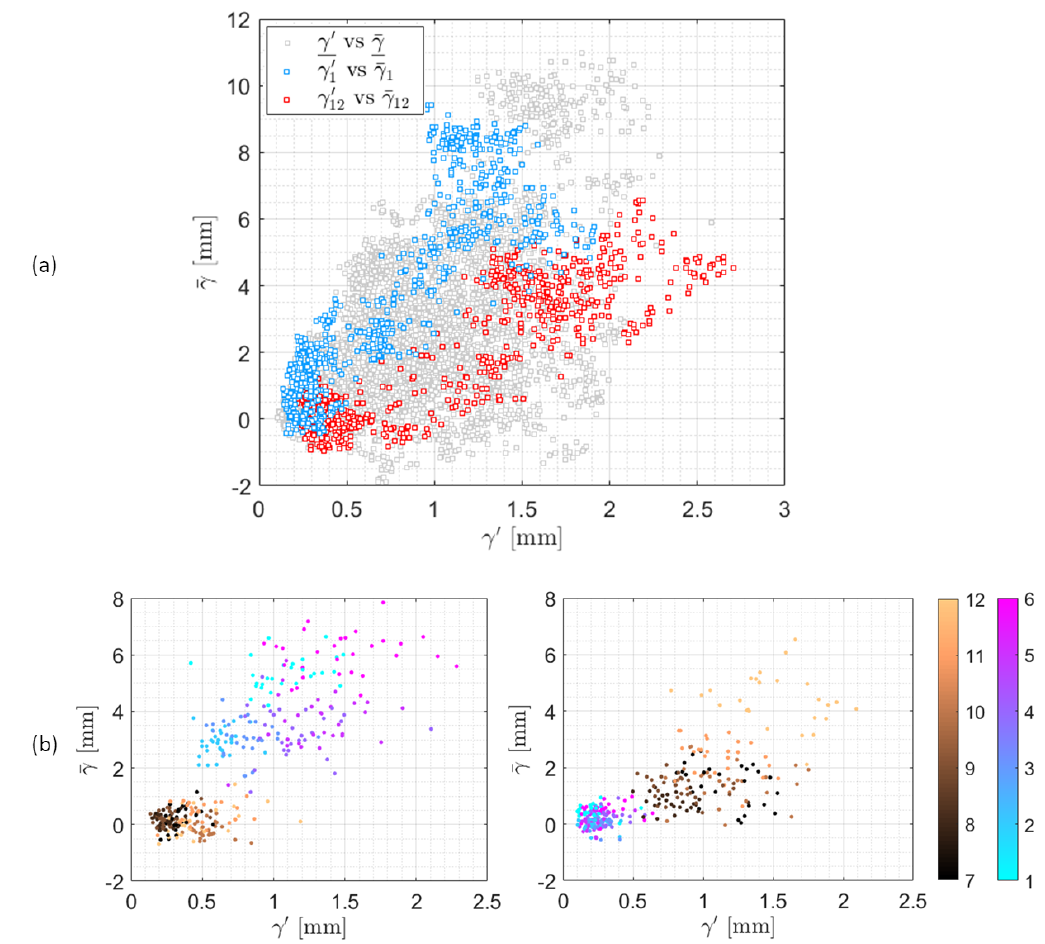
Figure 4. Distribution of the mean and fluctuating deflection samples (inputs to the learning models) for the 12 whiskers in the ( γ (cid:48) , ¯ γ ) space: ( a ) population of the complete input dataset that correspond to all positions of the cylinder. Highlighted in blue and red are the data samples of the whiskers numbered 1 and 12 respectively. ( b ) input samples of two selected recordings that correspond to the cylinder positions ( − 15,75) and (5,75). The scattered sample points are coloured by their whisker indexes as represented by the colour